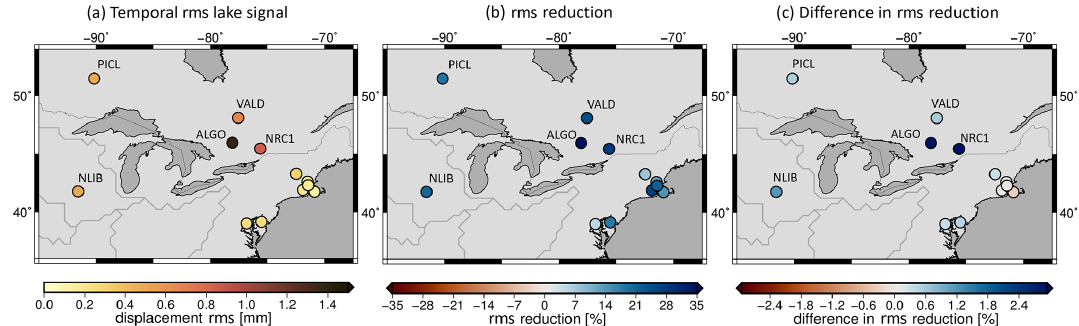
Figure 9. Temporal rms of the vertical displacement caused by the forward-modelled lake/reservoir signal of RECOG-LR (a) , reduction of rms of GNSS time series after subtracting modelled deformation (b) , and difference in rms reduction when subtracting GRACE after removing and relocating RECOG-LR vs. using the uncorrected GRACE signal (c)